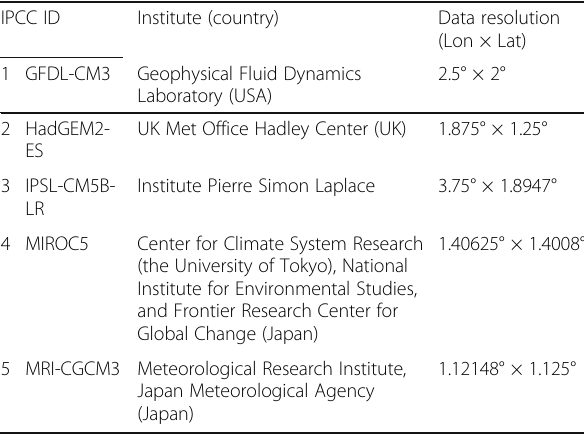
Table 1 CMIP5 model outputs used in this study. Data resolution information is obtained from the website of the European Network for Earth system Modeling (2019) IPCC ID Institute